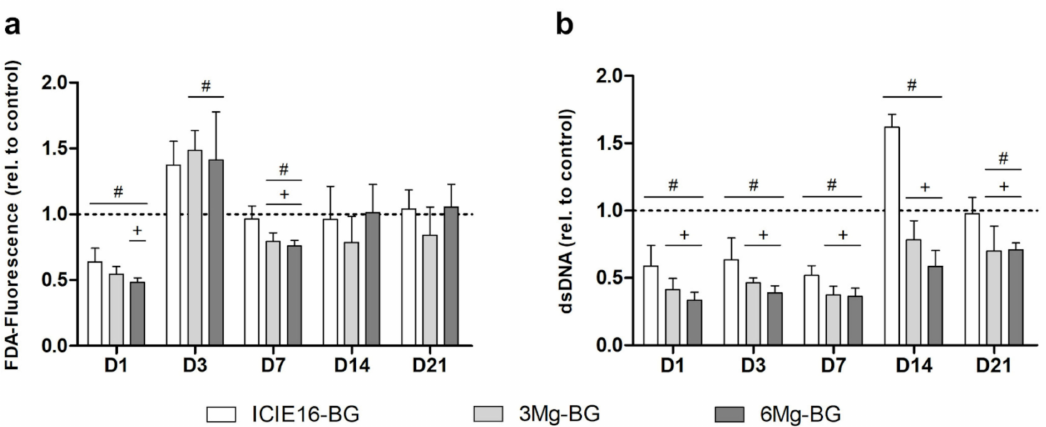
Figure 3. Development of cell viability based on fluorescein diacetate-(FDA-)fluorescence ( a ) and cell proliferation via PicoGreen assay ( b ) from day (D)1 to D21. Results are shown as relative values being normalized to the control group which is depicted by the dotted line. All values are displayed as means with standard deviation. (#) indicates significant difference to the control group and (+) presents significant differences to ICIE16-bioactive glass